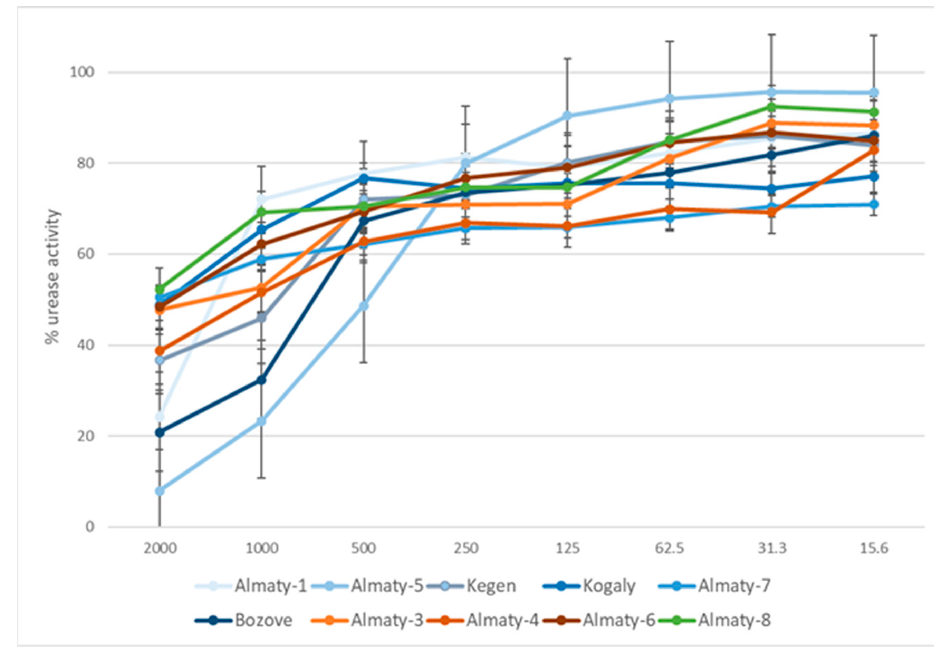
Figure 3. Urease activity inhibition by tested 70EEP of Kazakh propolis.